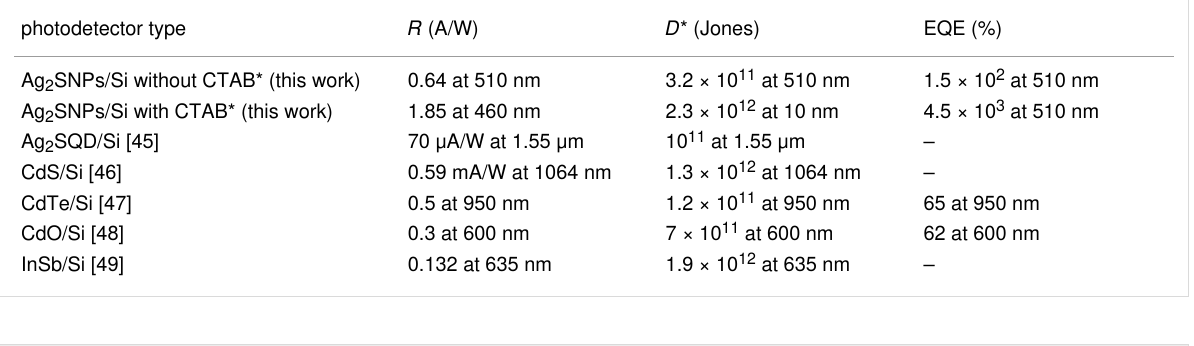
Table 1: Figures of merit of Ag 2 S/Si photodetector and other silicon heterojunction photodetectors.